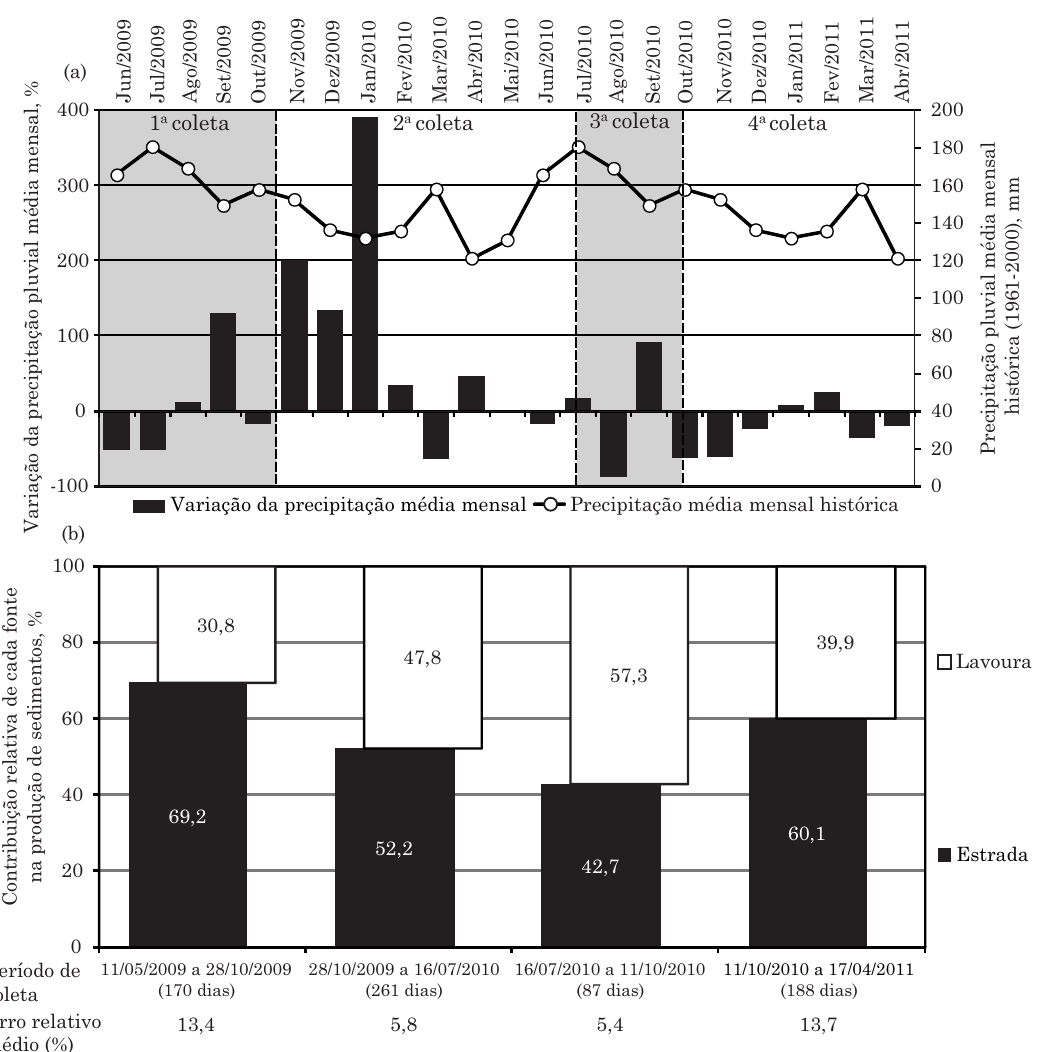
Figura 2. a) variação da precipitação pluvial média mensal durante os períodos de coleta de sedimento em suspensão (relação entre precipitação média mensal histórica e precipitação mensal durante o período de estudo) e precipitação pluvial média mensal histórica (1961-2000); e b) Contribuição relativa das áreas de lavoura e da estrada na produção de sedimentos na bacia hidrográfica do Assentamento Alvorada, Júlio de Castilhos, Rio Grande do